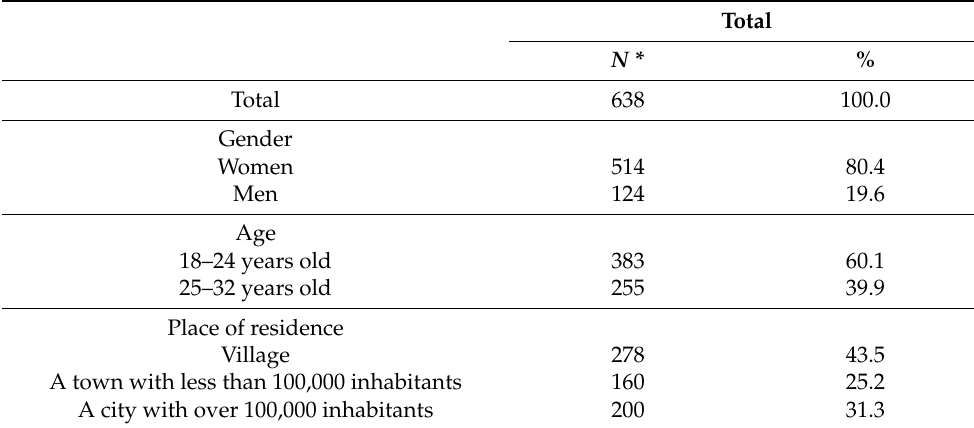
Table 2. Characteristics of the study